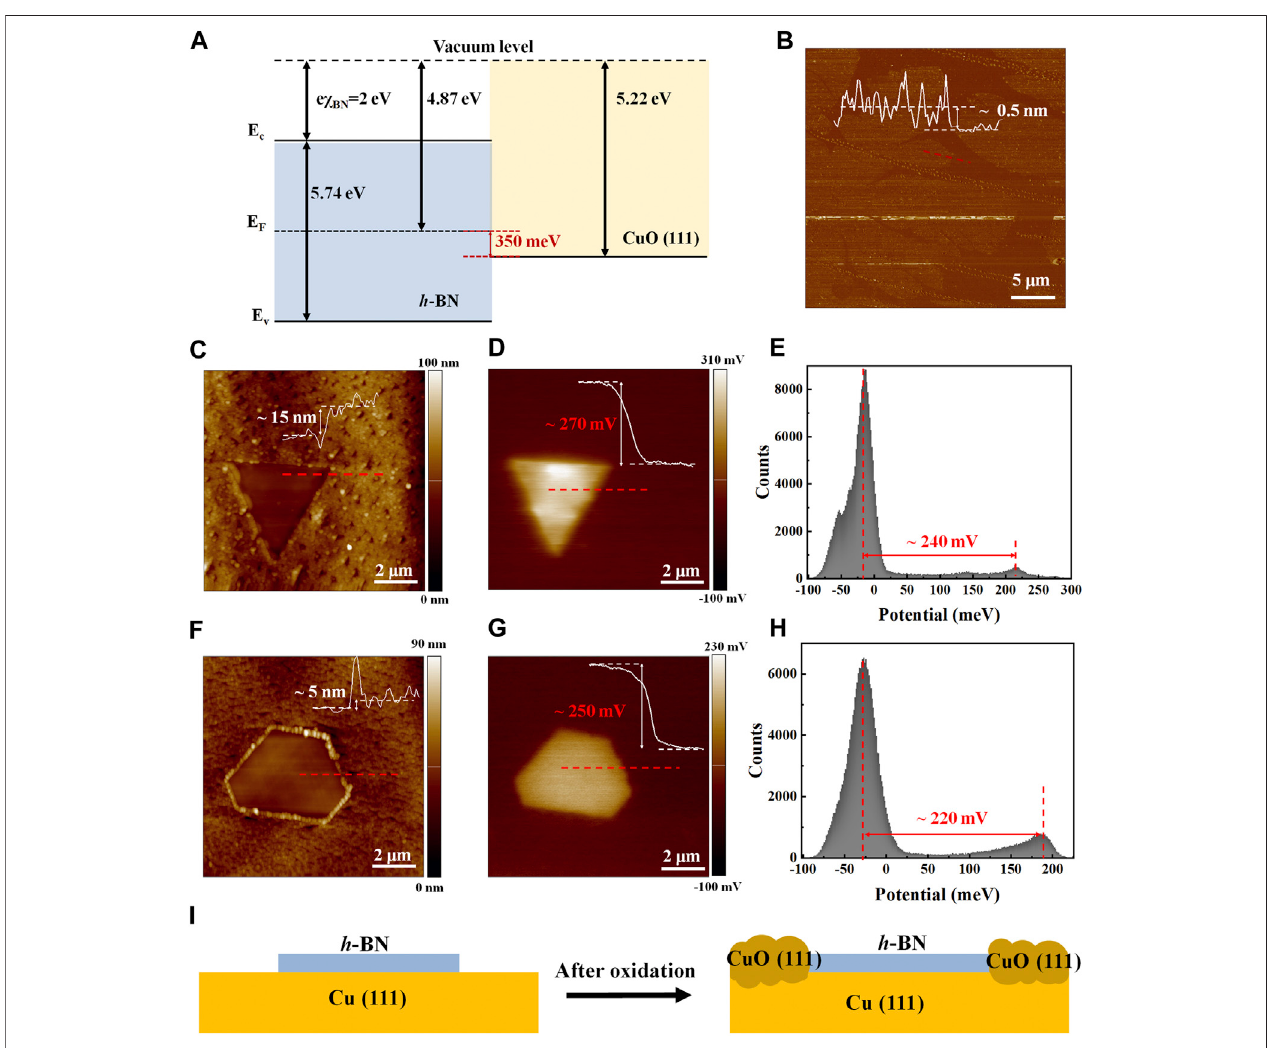
FIGURE 5 | AFM KPFM measurements of monolayer h -BN nano fl akes on Cu after oxidation. (A) The band diagram of h -BN and CuO (111). (B) AFM image of transferred h -BN nano fl akes on SiO 2 /Si substrate. AFM height images of (C) triangle and (F) hexagonal monolayer h -BN nano fl akes on CuO (111). KPFM surface potential maps of (D) triangle and (G) hexagonal monolayer h -BN nano fl akes on CuO (111). The histogram distributions of the surface potentials for (E) triangle and (H) hexagonal monolayer h -BN nano fl akes on CuO (111). (I) Schematic of the h -BN/Cu before and after the